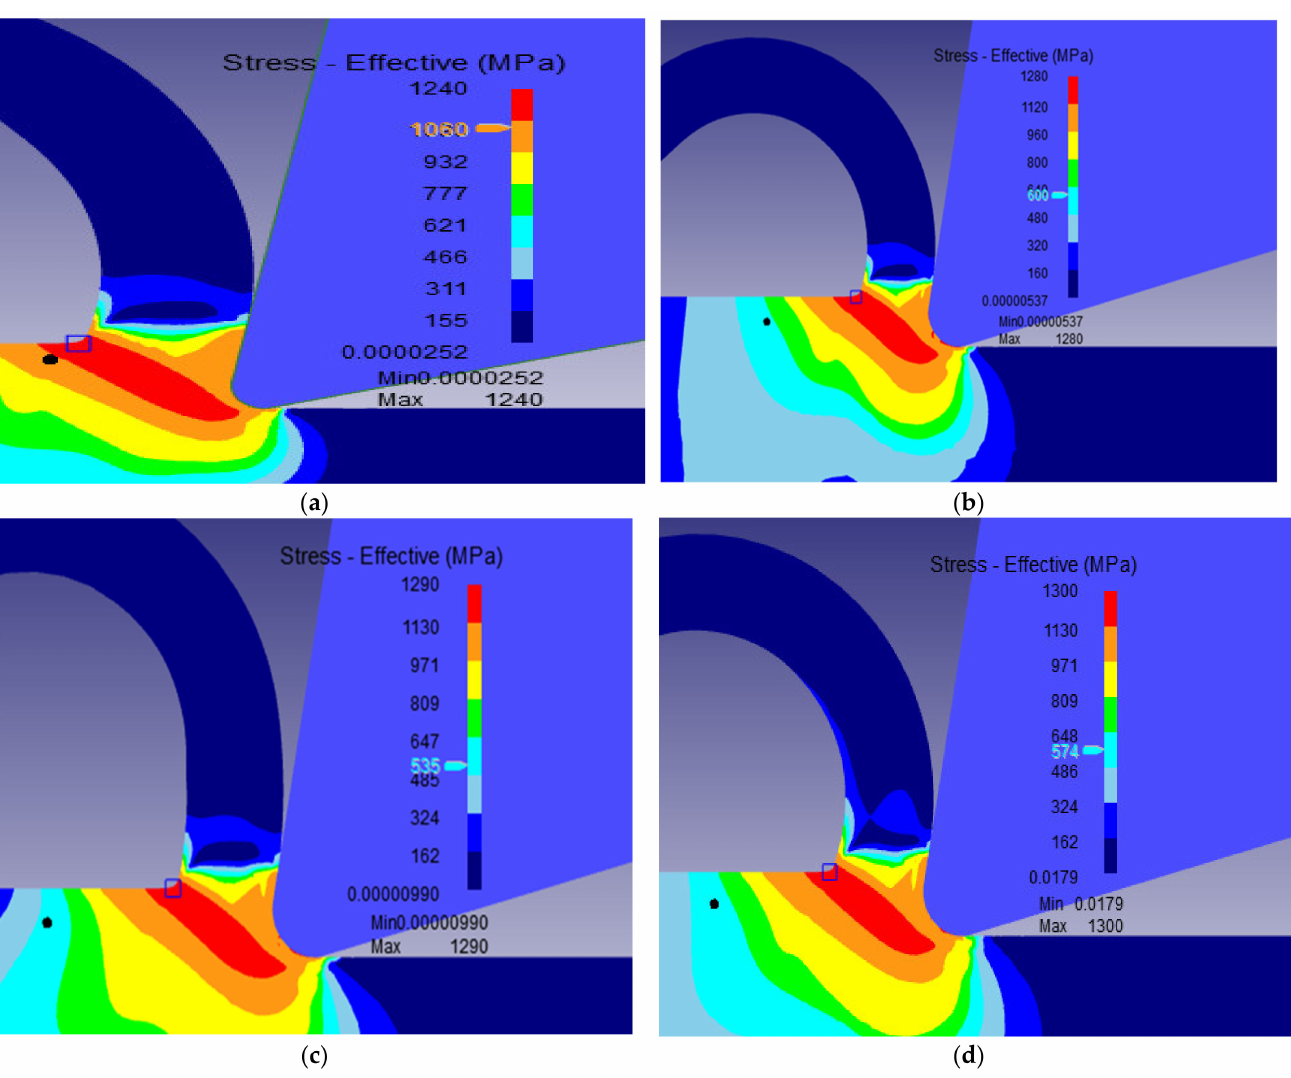
Figure 6. Distribution of effective stress in the workpiece and cutting tool at V = 400 m/min f = 0.1 mm/rev, γ = 5 ◦ for the nose radii r c : ( a ) 0.3 mm, ( b ) 0.5 mm ( c ) 0.7 mm and ( d ) 0.9